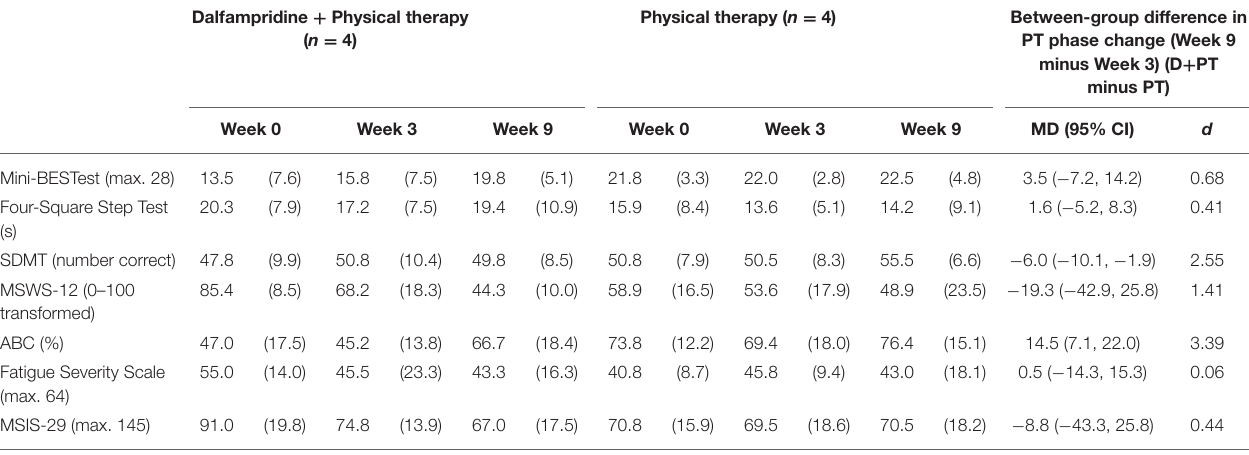
TABLE 3 | Mean (SD) for secondary outcome measures and between-group differences in change during physical therapy (PT) intervention phase (Week 3–9). Dalfampridine + Physical therapy Physical therapy ( n = 4) Between-group difference in ( n = 4) PT phase change (Week